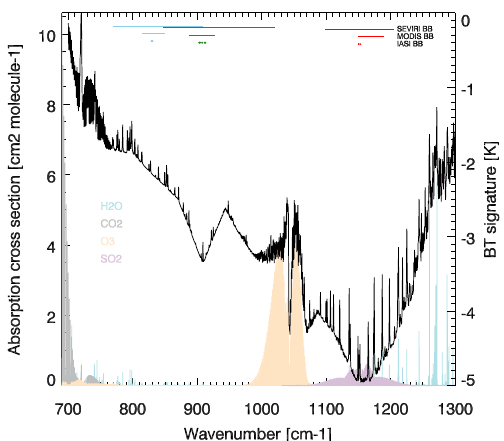
Figure 9. Absorption cross sections of water vapour (multiplied by a factor of 30 to enhance visualisation; light blue), carbon diox- ide (grey), ozone (orange) and sulfur dioxide (violet) in the spec- tral range 700–1300cm − 1 . A typical sulfate aerosol BT signature is overplotted (black). The spectral ranges of the channels used for IASI BB, MODIS BB and SEVIRI BB instrumental configurations (broadband features) are also reported (sky blue, green and red lines and